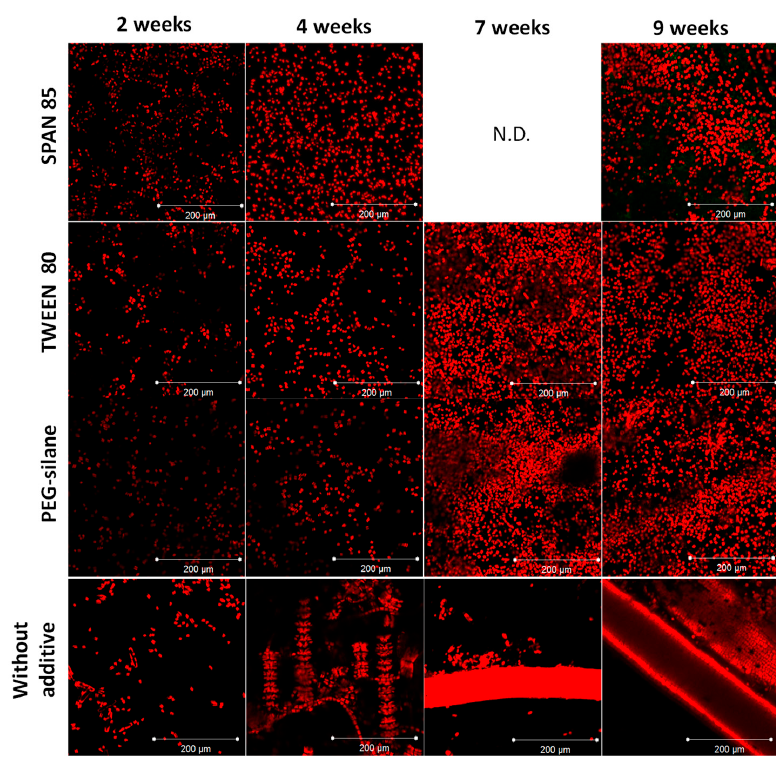
Figure 5. Maximum intensity projection data sets from microalgal biofilms on paints made by confocal laser scanning microscopy after 2, 4, 7 and 9 weeks of immersion in natural seawater (Kernevel Harbour). Microalgae were observed in red by autofluorescence of chlorophyll. N.D. not determined because of technical problems.